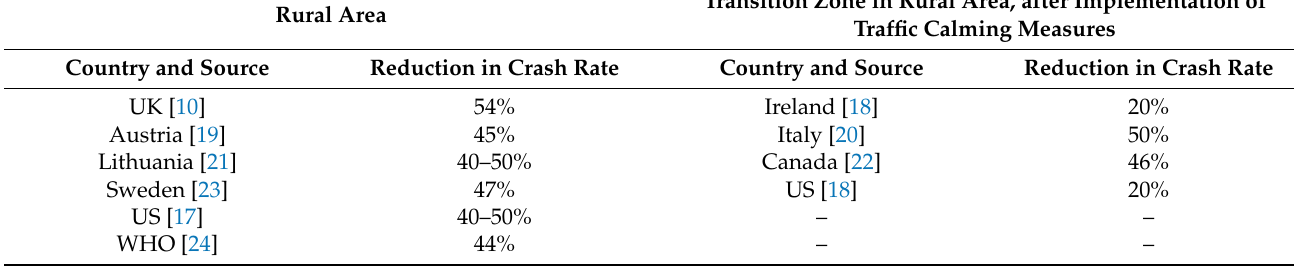
Transition Zone in Rural Area, after Implementation of Traffic Calming Measures